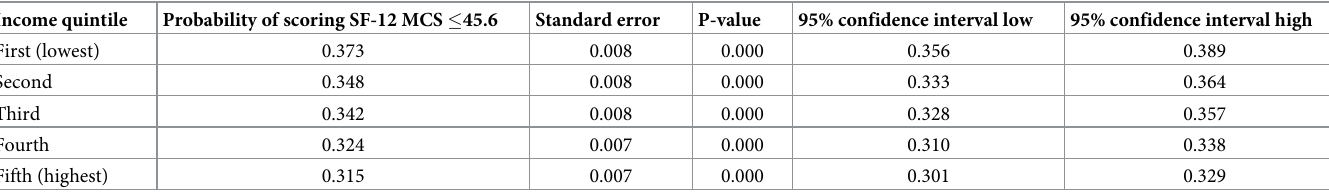
Table 3. Adjusted prediction of an individual scoring SF-12 MCS � 45.6 indicating clinical depressive disorder by net equivalised household income quintiles. Probability of scoring SF-12 MCS � 45.6